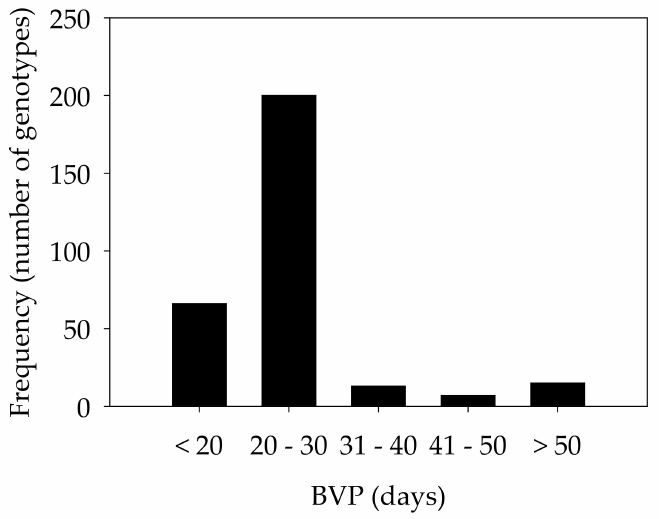
Figure 1. Frequency distribution of basic vegetative phase (BVP) for 301 Thai indigenous upland rice